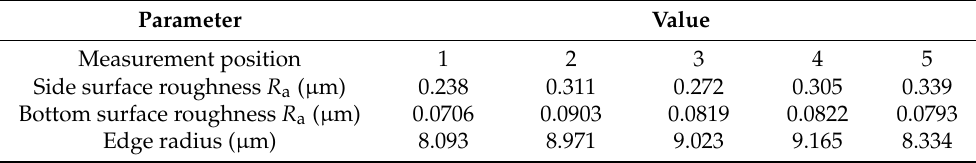
Figure 15. The morphology observation of the open-type waveguide half-cavity: ( a ) SEM example of local amplification morphology, ( b ) SEM example of internal edge radius, ( c ) AFM example of the inner side surface roughness, ( d ) AFM example of the inner bottom surface roughness. Table 7. Measurement results of machining indicators of the open waveguide cavity.